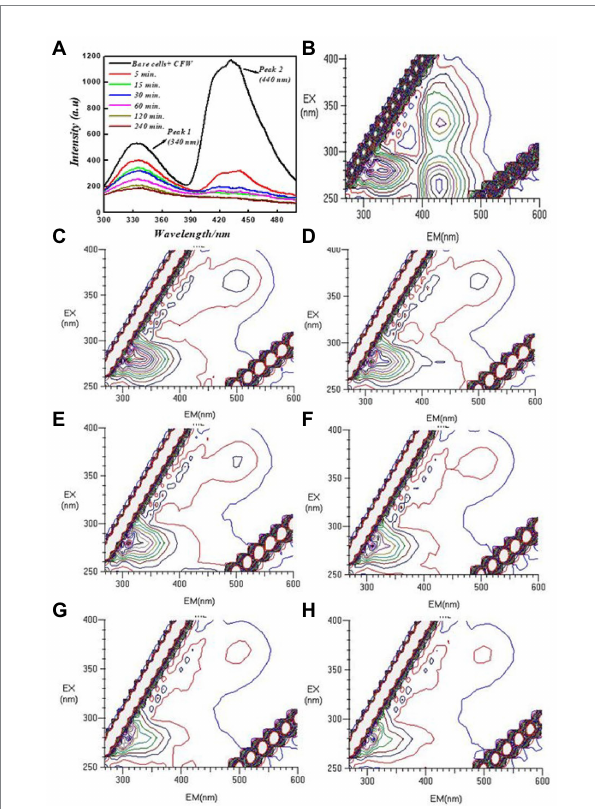
FIGURE 5 2D and 3D FL emission spectra of calcofluor white-stained C. albicans cells at various incubation times treated with PEI-f-Ag-NPs and without treatment: (A) 2D FL emission spectrum, (B) 3D FL spectrum without PEI-f-Ag-NPs (cell control), (C) 3D FL spectrum involving incubation with PEI-f-Ag-NPs for 5 min, (D) 3D FL spectrum involving incubation with PEI-f-Ag-NPs for 15 min, (E) 3D FL spectrum involving incubation with PEI-f-Ag-NPs for 30 min, (F) 3D FL spectrum involving incubation with PEI-f-Ag-NPs for 60 min, (G) 3D FL spectrum involving incubation with PEI-f-Ag-NPs for 120 min, and (H) 3D FL spectrum involving incubation with PEI-f-Ag- NPs for 240